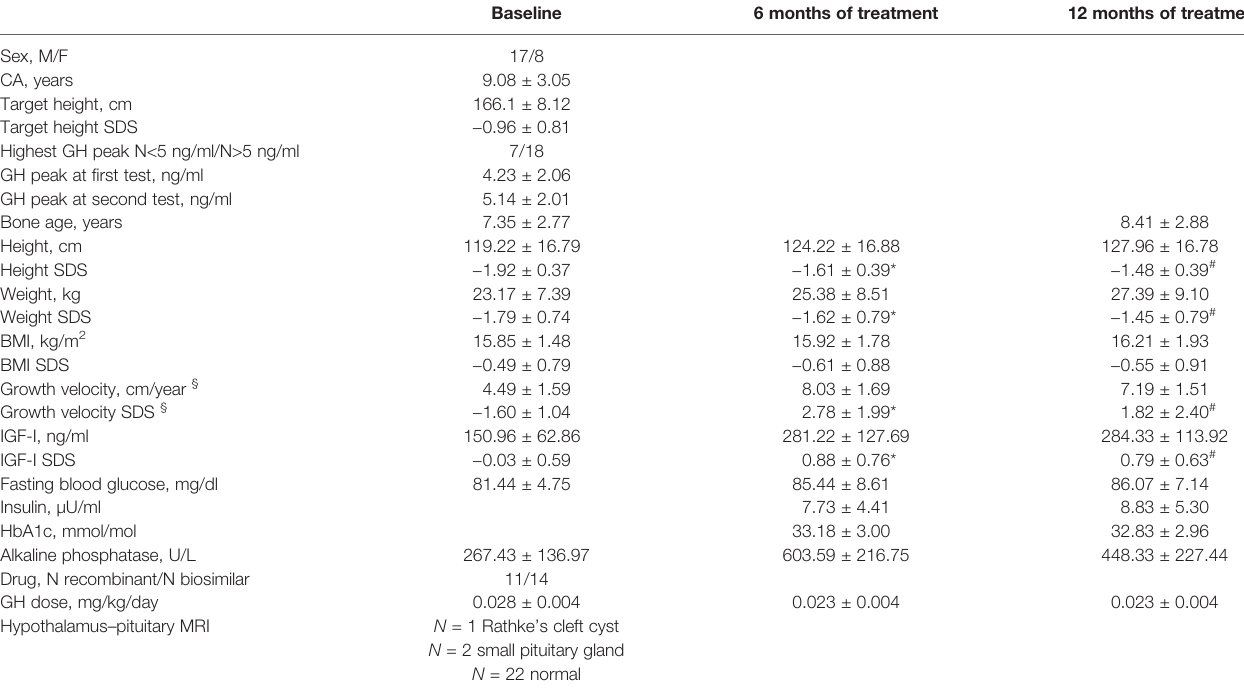
BMI,bodymassindex;CA,chronologicalage;F,females;FBG,fastingbloodglucose;GH,growthhormone;HbA1c,glycatedhemoglobin;IGF-I,insulin-likegrowthfactor1;M,males;N, number;SD,standarddeviation;SDS,standarddeviationscore;U,units. § calculatedontheprevious6months.*p<0.0001baselinevs.6monthsontreatment. #